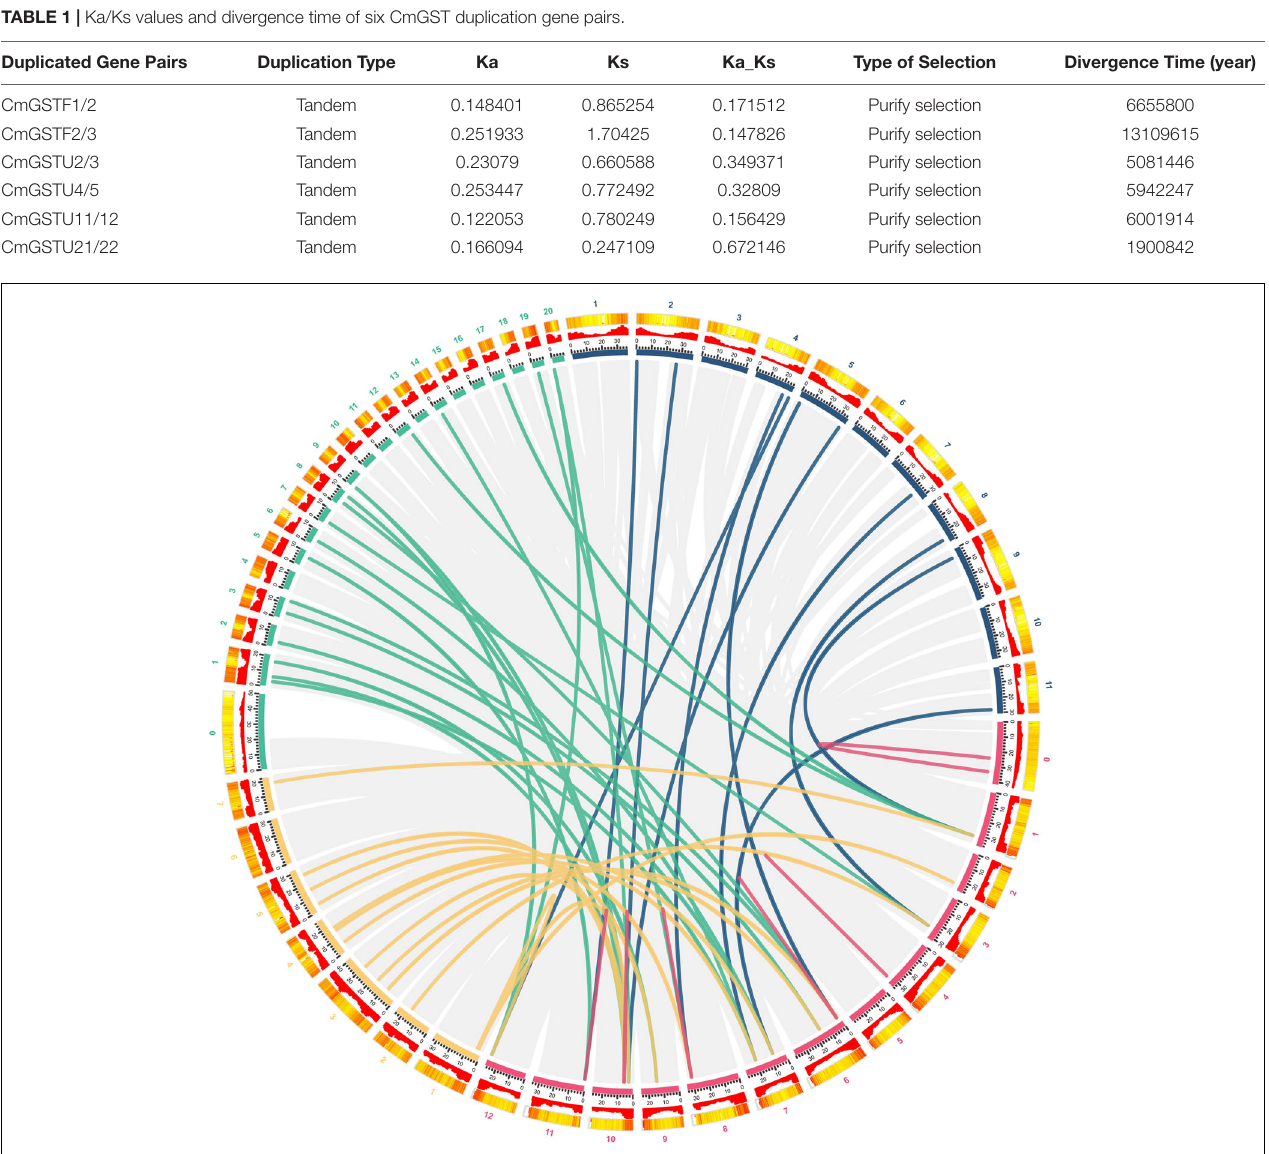
FIGURE 3 | Syntenic analysis of GST genes from Hami melon, cucumber, zucchini squash, and watermelon. Red, yellow, green, and blue curves represent homologous gene pairs between Hami melon/Hami melon, Hami melon/cucumber, Hami melon/zucchini squash, and Hami melon/watermelon, respectively. Gray lines represent collinear gene pairs in Hami melon/Hami melon, Hami melon/watermelon, Hami melon/zucchini squash, and Hami melon/cucumber genomes.